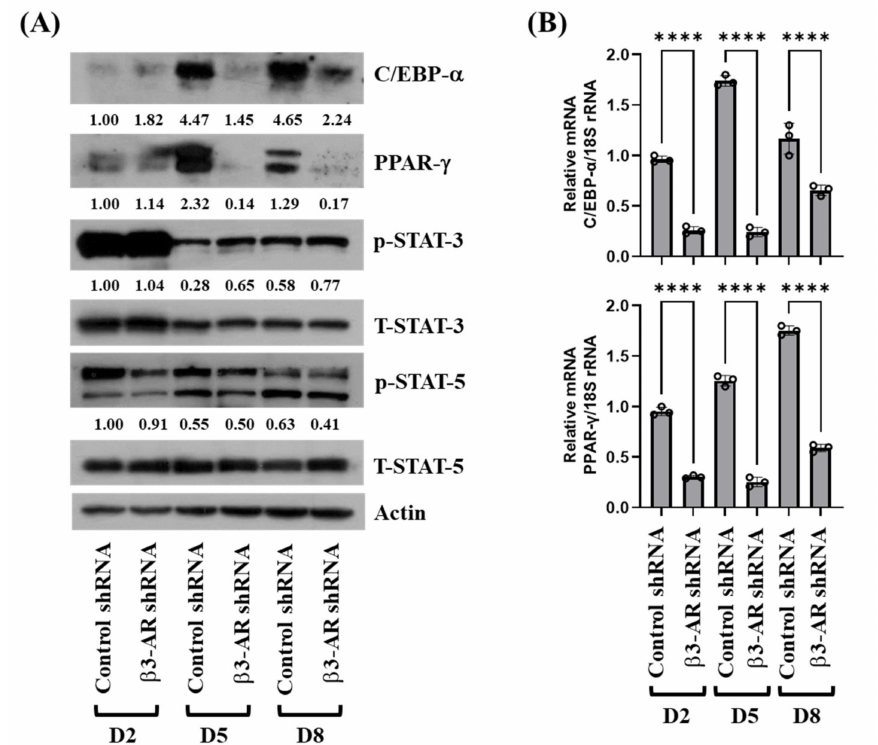
Figure 4. Effects of gene silencing of β 3-AR on expression and phosphorylation of C/EBP- α , PPAR- γ , STAT-3, and STAT-5 during 3T3-L1 preadipocyte differentiation. ( A ) 3T3-L1 preadipocytes were stably transfected with 100 pM of control or β 3-AR shRNA. Control or β 3-AR shRNA-transfected cells were differentiated with an induction medium containing MDI, insulin, and FBS, and harvested at day 0 (D0), D2, D5, and D8, respectively. At each time point, whole-cell lysates were prepared and analyzed by immunoblot analysis with respective antibodies. Relative intensities were measured by ImageJ software (version 1.8.0; National Institutes of Health, Bethesda, MD, USA). ( B ) 3T3-L1 preadipocytes were stably transfected with 100 pM of control or β 3-AR shRNA. Control or β 3-AR shRNA-transfected cells were differentiated with an induction medium containing MDI, insulin, and FBS, and harvested at day 0 (D0), D2, D5, and D8, respectively. At each time point, total cellular RNA was prepared and analyzed by real-time qPCR with respective primers. Error bars are indicated as mean ± SD. **** p < 0.0001; calculated by one-way ANOVA with Sidak’s multiple comparison